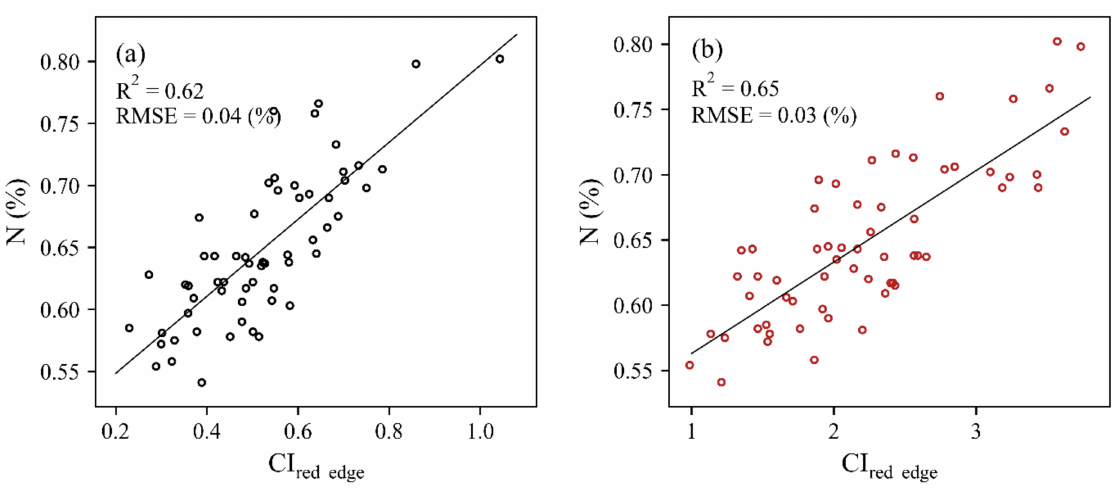
Figure 6. Linear relationship between CI red edge and N concentration for the ( a ) HSL and ( b ) ASD dataset. With ten spectral indices as inputs, the PLSR model exhibited a good ability to estimate the N concentration, since the data points were closer to the 1:1 line (Figure 7). The fitness between the measured and estimated values of PLSR was better than that obtained using spectral indices, with the estimation accuracy of ASD (R 2 = 0.70, RMSE = 0.03%) being higher than that of HSL (R 2 = 0.66, RMSE = 0.04%).